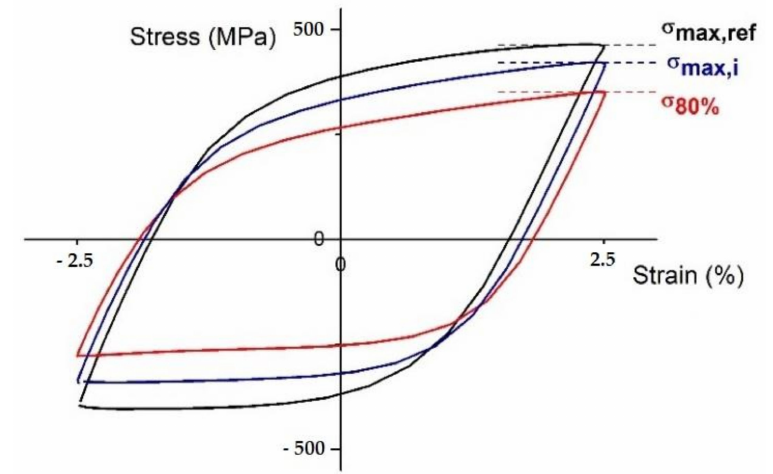
Figure 6. Definition of significant values of